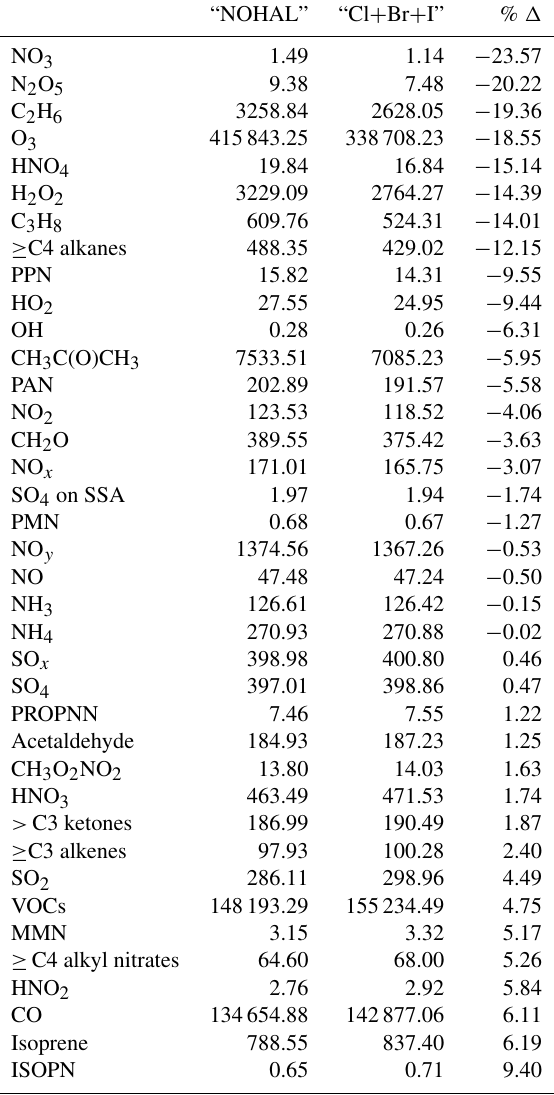
Table A1. Tropospheric burden of species and families with (“Cl + Br + I”) and without halogens (“NOHAL”), and % change. Burdens are considered in elemental terms (e.g Gg S/N/C) and species masses for OH, HO 2 , H 2 O 2 , and O 3 . Families are defined in Appendix